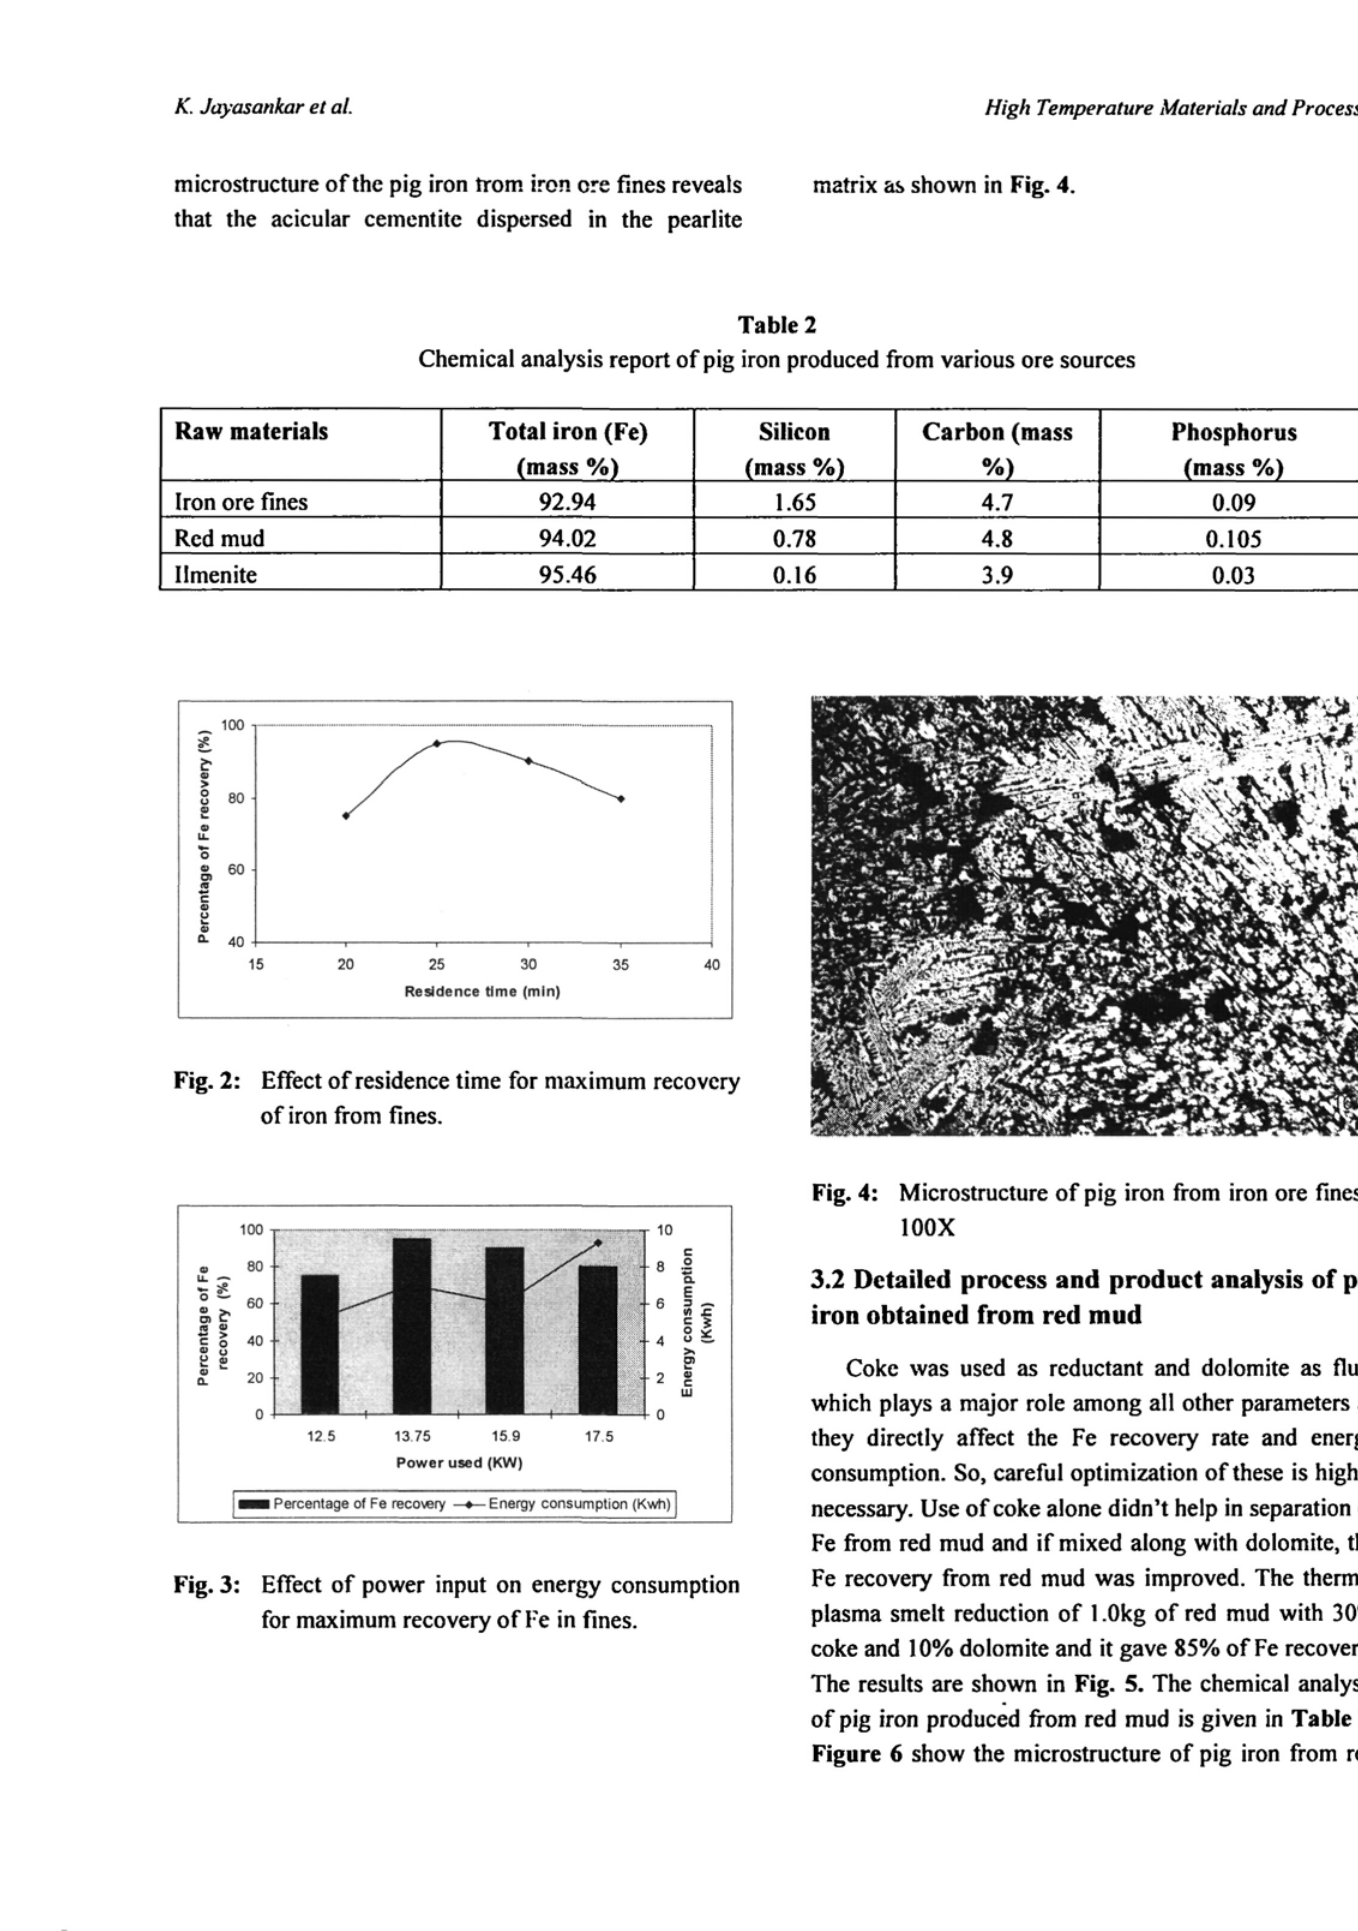
Fig. 3: Effect of power input on energy consumption for maximum recovery of Fe in fines.